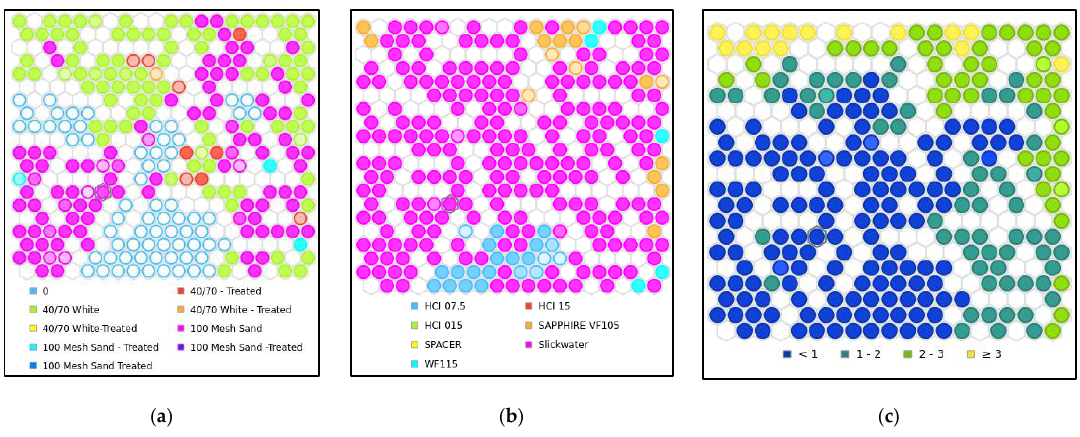
Figure 16. An unsupervised learning algorithm clusters the data using a SOM; ( a ) proppant size, ( b ) fluid type, and ( c ) proppant concentration.